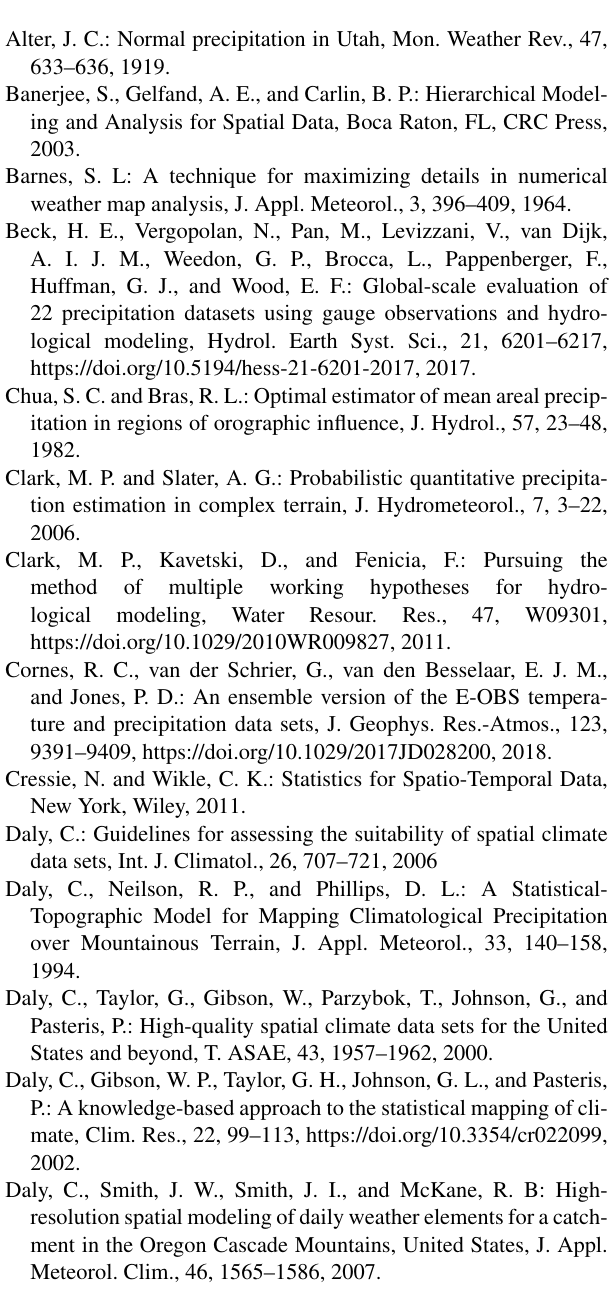
table_gallery.shtml, last access: 7 June 2019,